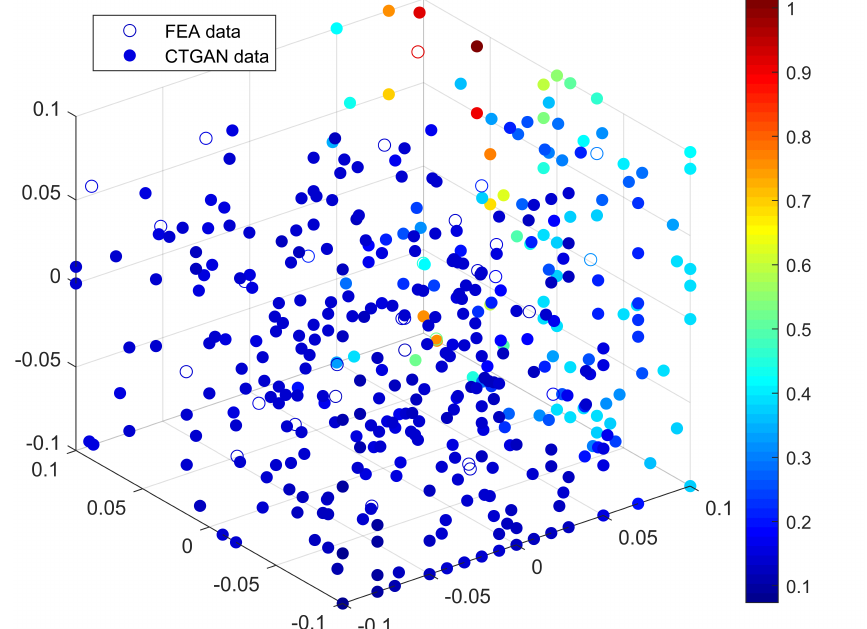
Figure 8. Data expansion with